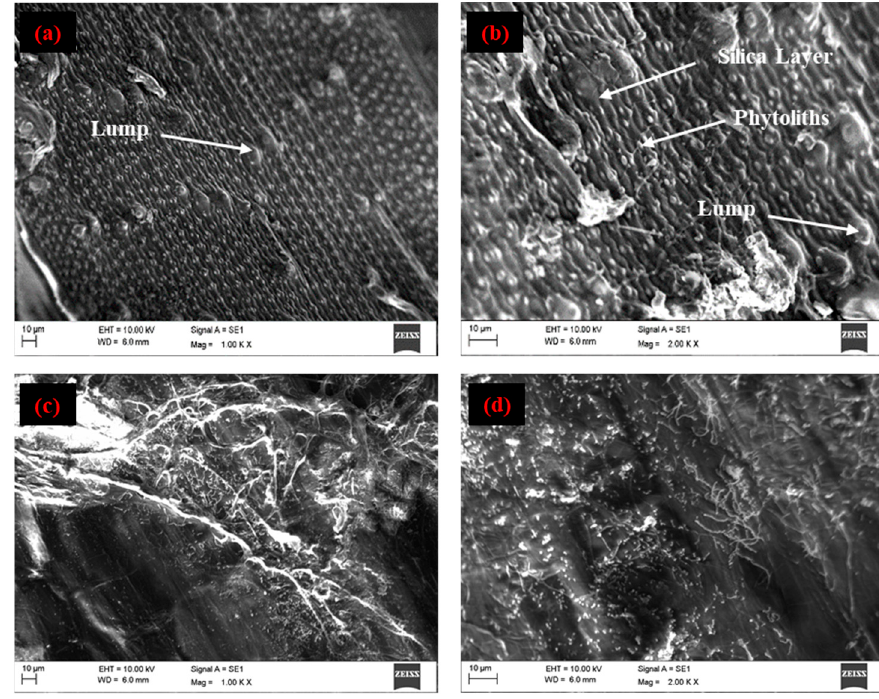
Figure 4. Microscopic view. ( a , b ) outer surface and ( c , d ) inner surface of RS.